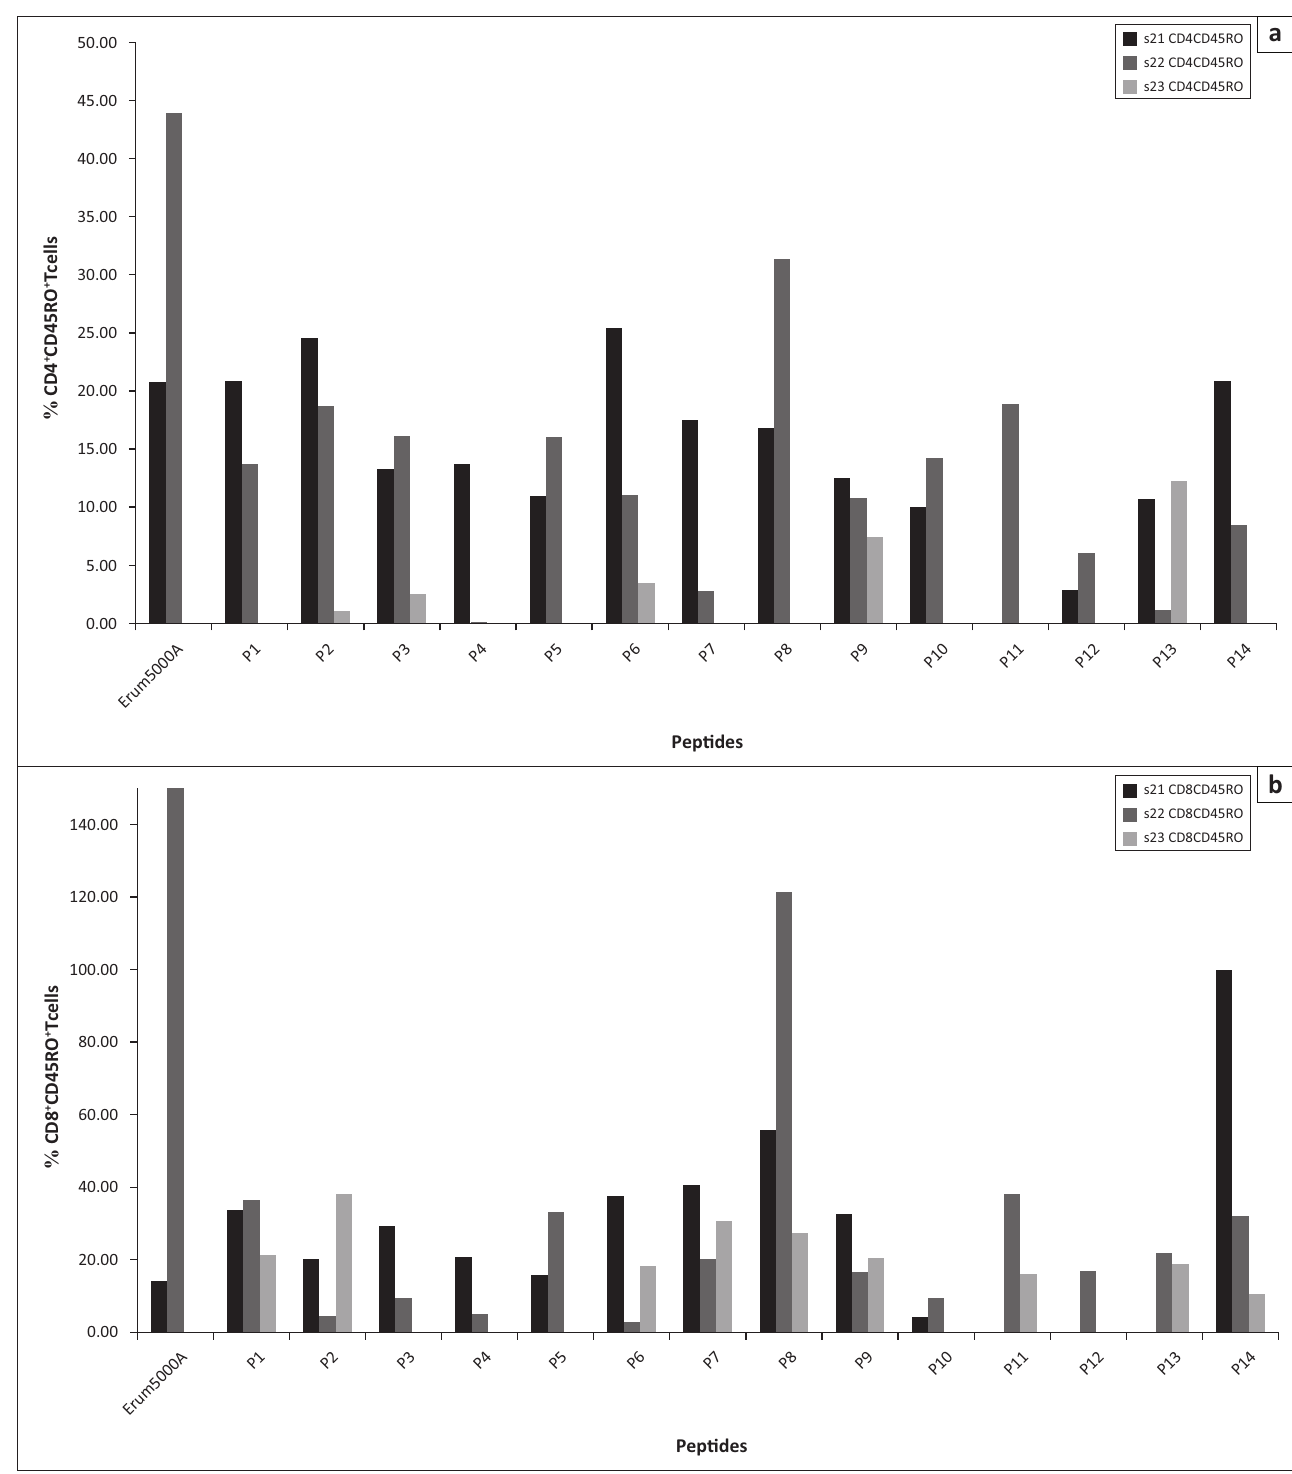
FIGURE 2: Percentage of cells expressing CD4+CD45RO+ (a) and CD8+CD45RO+ (b) surface markers after peripheral blood mononuclear cells stimulation with Erum5000A peptides for 48 h in vitro .